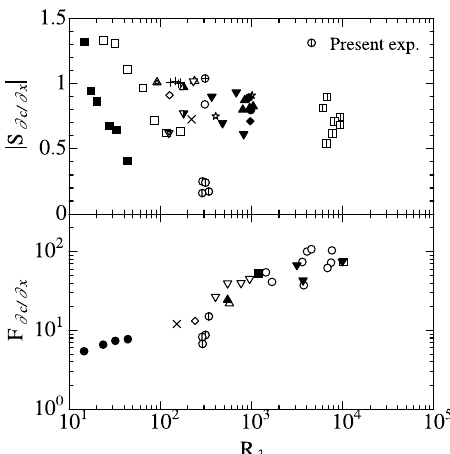
Fig. 8 Reynolds number variations of the skewness and flatness factor of the streamwise scalar derivative ∂ c /∂ x . All the data are reproduced from Sreenivasan and Antonia (1) except for the present experiments (cid:2) (cid:2) (cid:2) (cid:2) (cid:2) S (cid:2) is shown in the figure. As is the case of the velocity, all the data except for the ∂ c /∂ x